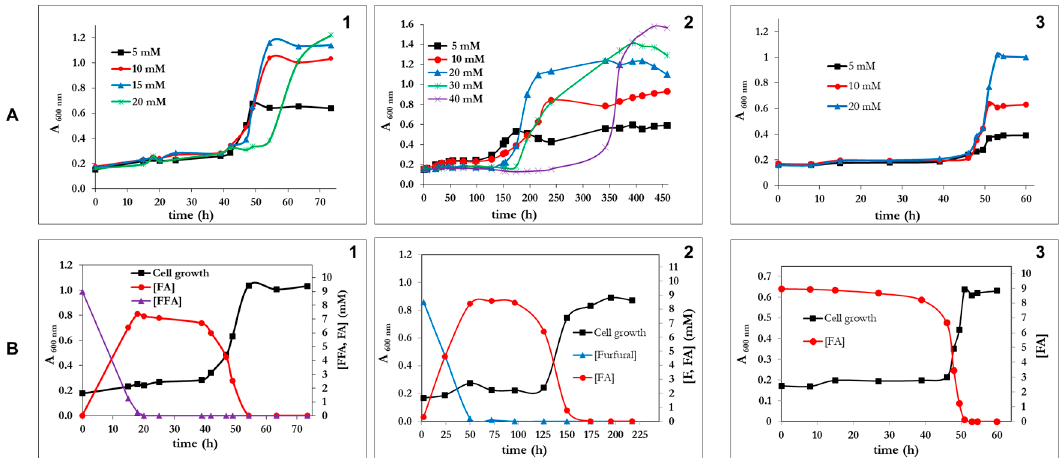
Figure 2. ( A ) Growth curves of Pseudomonas pseudoalcaligenes CECT 5344 R1 with different concentrations of furfuryl alcohol (panel A1), furfural (panel A2) or furoic acid (panel A3). ( B ) Growth curves and concentrations of furanic intermediates in the culture media of P. pseudoalcaligenes using as a carbon source either 5 mM furfuryl alcohol (panel B2), furfural (panel B2) or furoic acid (panel B3). Three independent experiments gave similar results.